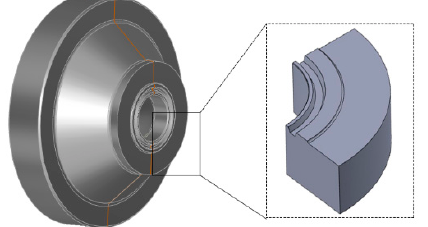
Figure 6. Three-dimensional schematic diagram of the test specimen.